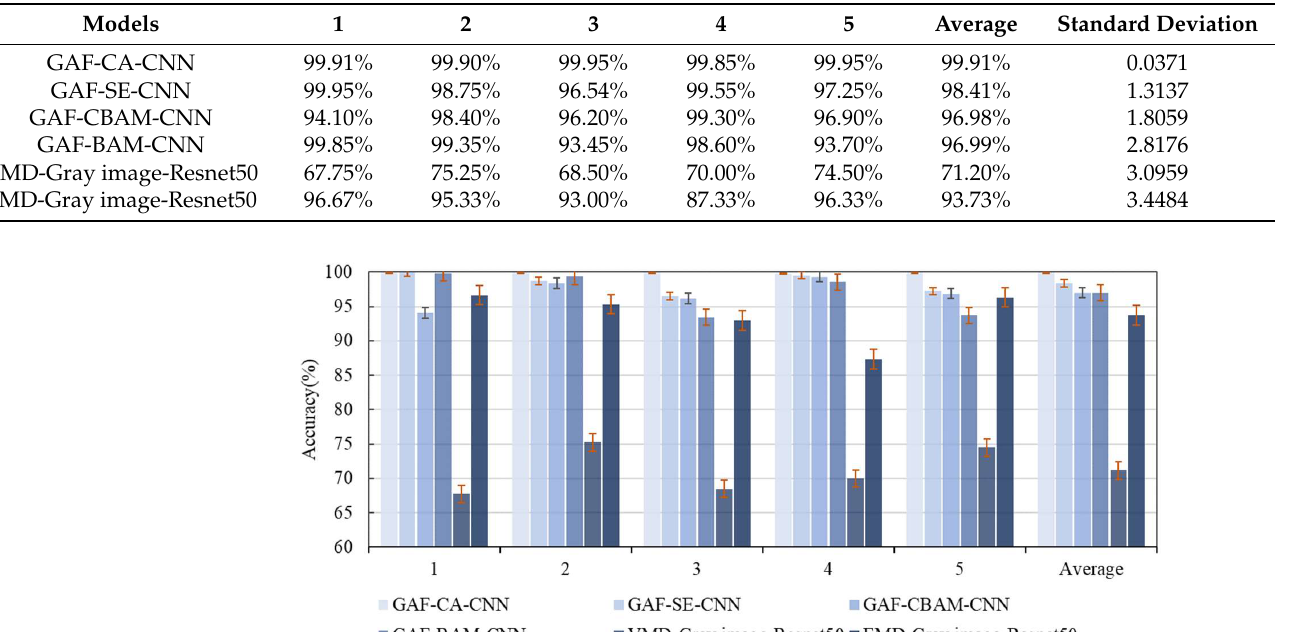
Figure 22. Comparison results between seven methods on dataset B.